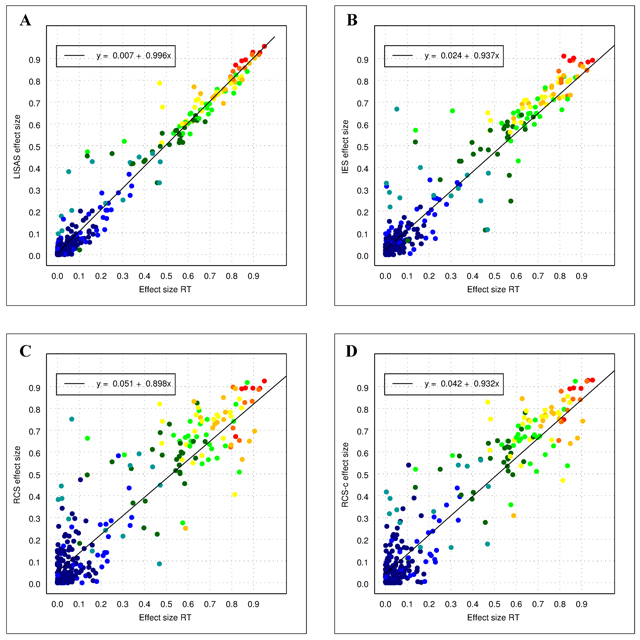
Effect sizes of all the effects in both Data Sets in LISAS (panel A), IES (panel B), RCS (panel C), and RCS-c (panel D) as a function of the effect size in RT. The colours of the plotted points indicate the average effect size obtained by RT and PE: dark blue (up to 0.1), blue (<0.2), cyan (<0.3), dark green (<0.4), green (<0.5), yellow (<0.6), orange (<0.7), red orange (<0.8) and red (<1.0).